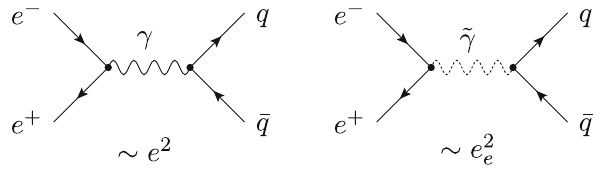
Fig. 2 Tree-leveldiagramscontributingtotheprocess e + e − → γ ∗ → q ¯ q . The interactionis mediatedby a photon γ ( left )andan (cid:3) -scalarpho- ton ˜ γ ( right ), respectively. The left diagram is present in all considered schemes, whereas the right one only exists in dred